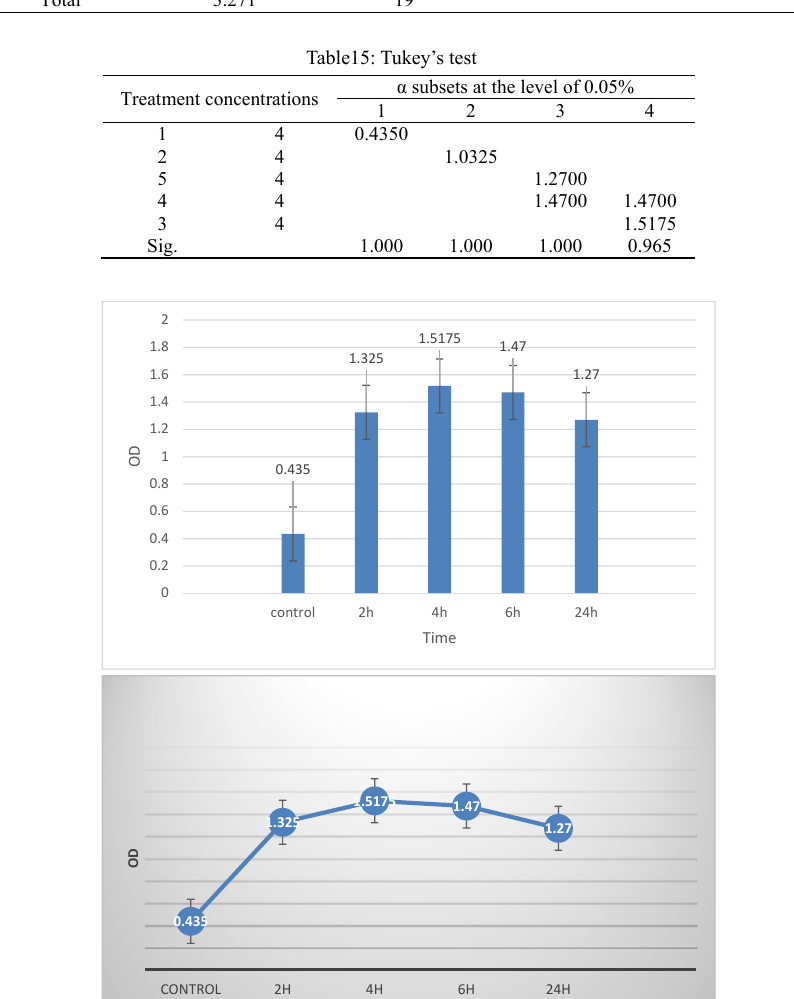
Table15: Tukey’s test